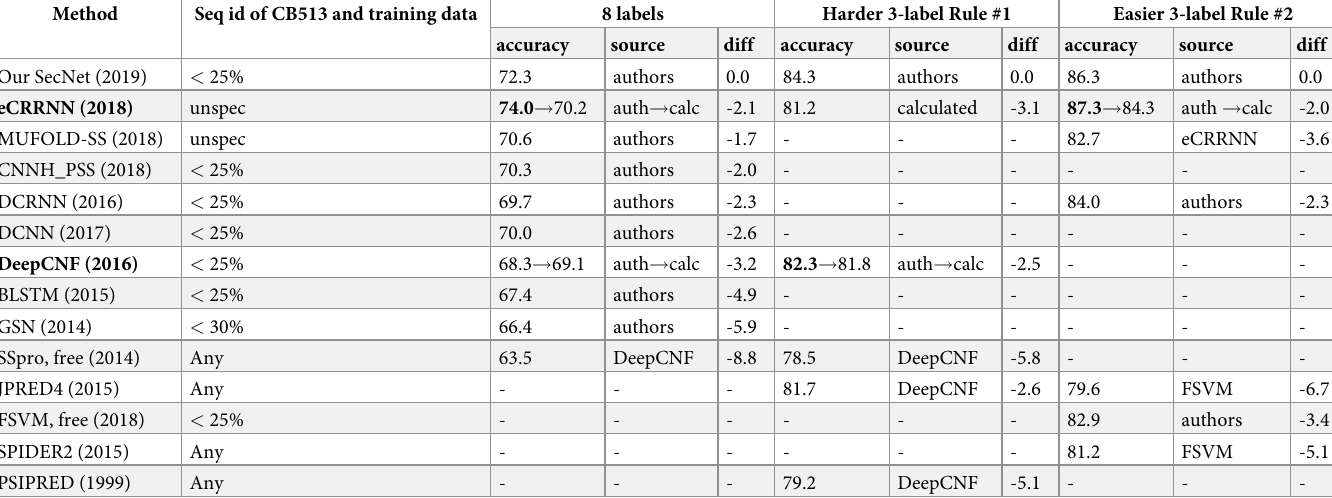
Table 5. CB513 accuracy of the 5 th -generation template-free secondary-structure prediction methods. Method Seq id of CB513 and training